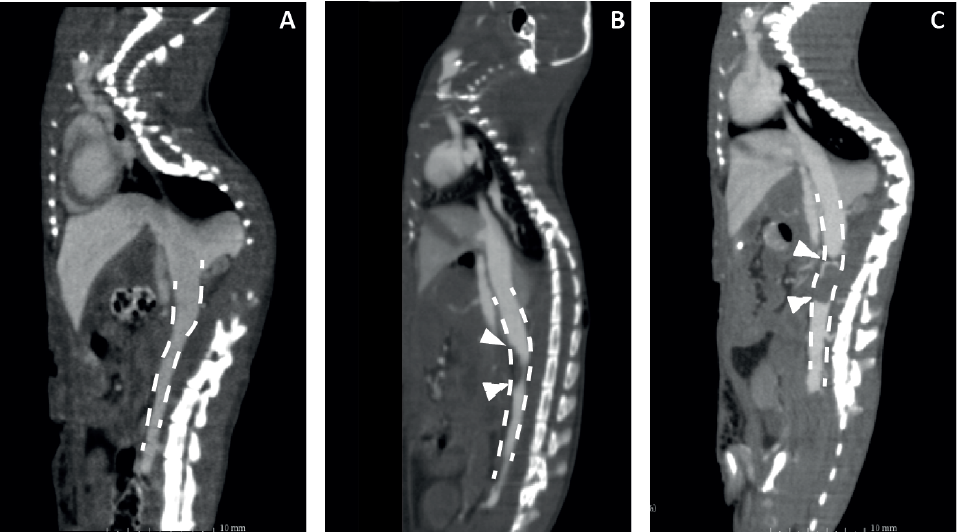
Figure 4. Evaluation of mouse DVT models by contrast-enhanced CT in a sham-operated mouse ( A ), 6 h after endothelial damage with FeCl 3 ( B ) and 24 h after flow restriction by partial ligation ( C ). The dashed line shows the IVC in the abdominal cavity. Arrowheads point to lack of intravenous contrast, indicating thrombus